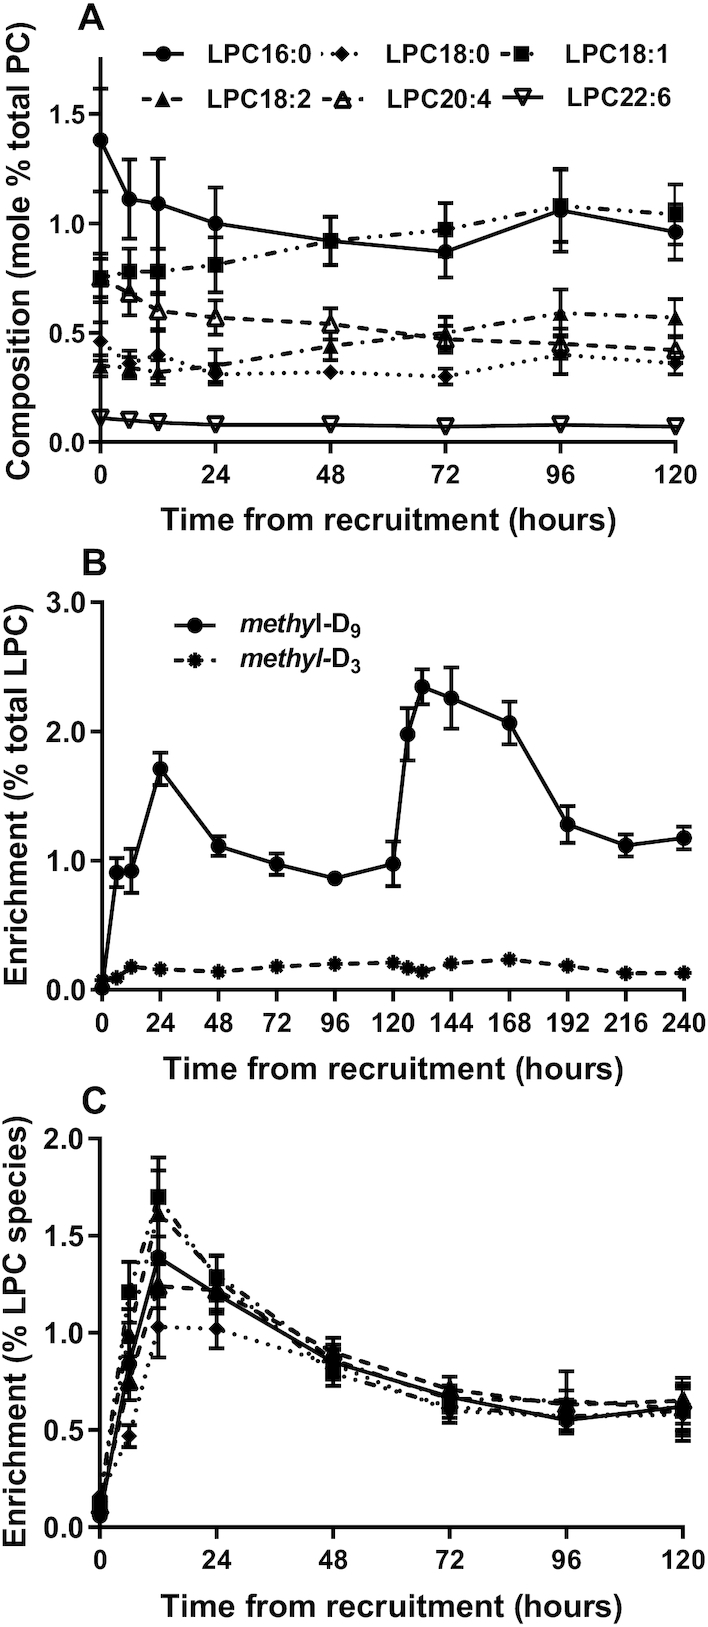
Synthesis of plasma LPC. (A) Composition of individual molecular species of plasma LPC (% total PC + LPC; mean ± SEM). (B) Enrichments of methyl-D9 (solid line) and methyl-D3 (dashed line) labels in plasma LPC species normalized to their initial concentrations at t = 0 h (mean ± SEM). (C) Enrichment of methyl-D9-choline in LPC species over the first 5 d after recruitment. Numbers at each time point were the same as in Figure 4A. LPC, lysophosphatidylcholine; PC, phosphatidylcholine.